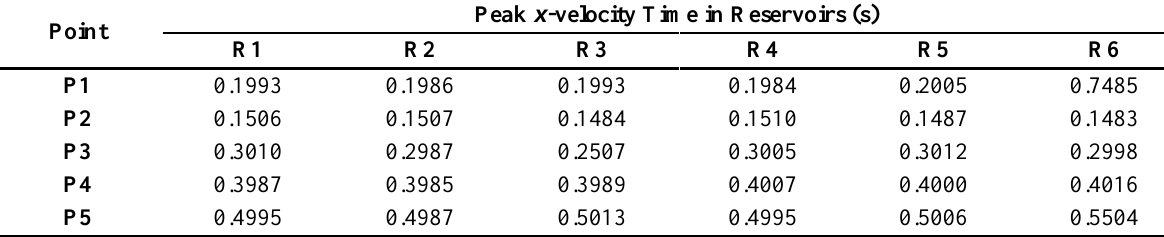
Time of peak velocity component in x direction.